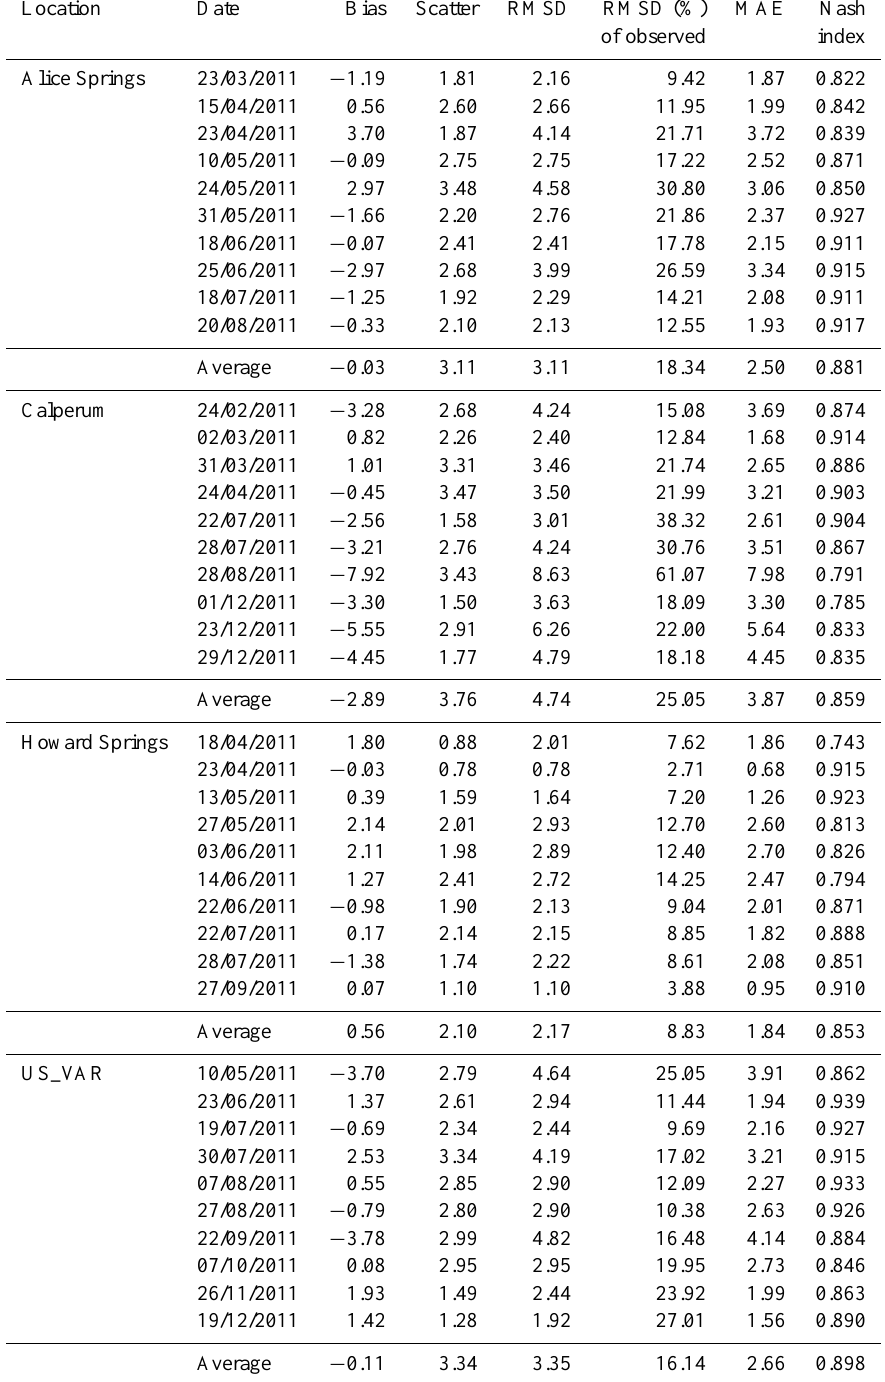
Table 7. Daily simulation accuracy and average site simulation accuracy for T air 1.3 m . Bias, scatter, RMSD and MAE are expressed in degrees Celsius. Nash index is